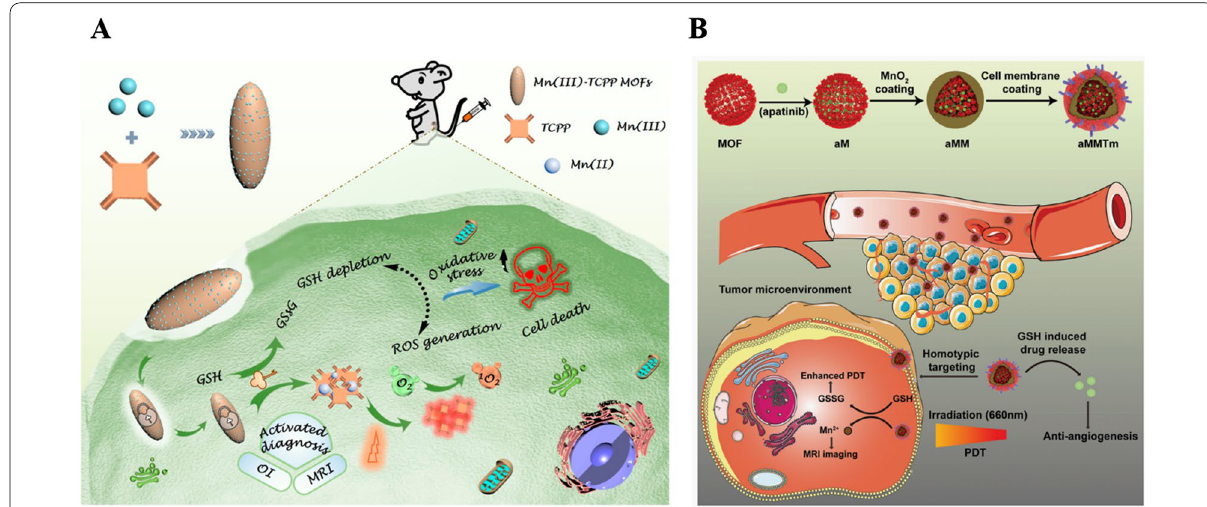
Fig. 4 Schematic illustration of an endocytosis Mn(III)-sealed MOF nanosystem for MRI and OI-guided PDT by controlled ROS generation and GSH depletion after being unlocked by overexpressed GSH in tumor cells [58]. Copyright 2019 American Chemical Society. B Schematic illustration of aMMTm preparation and proposed combination therapy of PDT and antiangiogenesis[55]. Copyright 2019 WILEY–VCH Verlag GmbH & Co. KGaA,